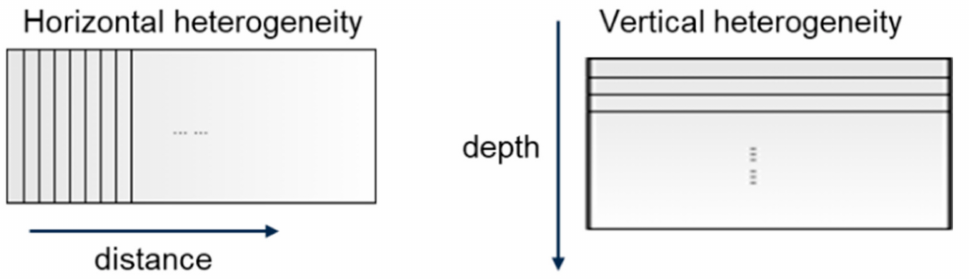
Figure 5. Horizontal and vertical heterogeneity in a simulation